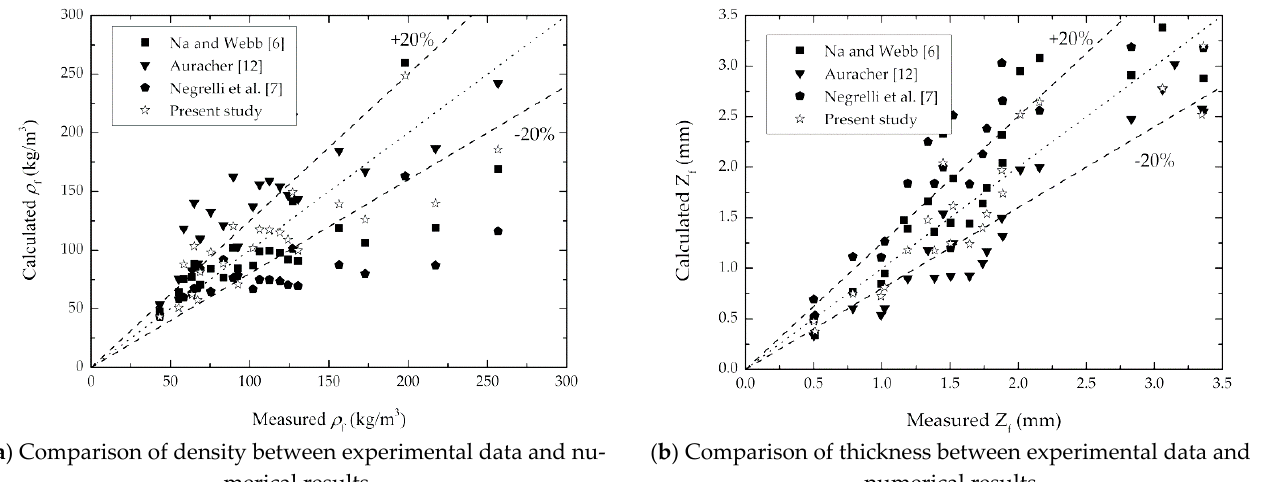
( a ) Comparison of density between experimental data and nu- merical results ( b ) Comparison of thickness between experimental data and numerical results Figure 9. The error analysis of predicted density and thickness by means of different correlations.